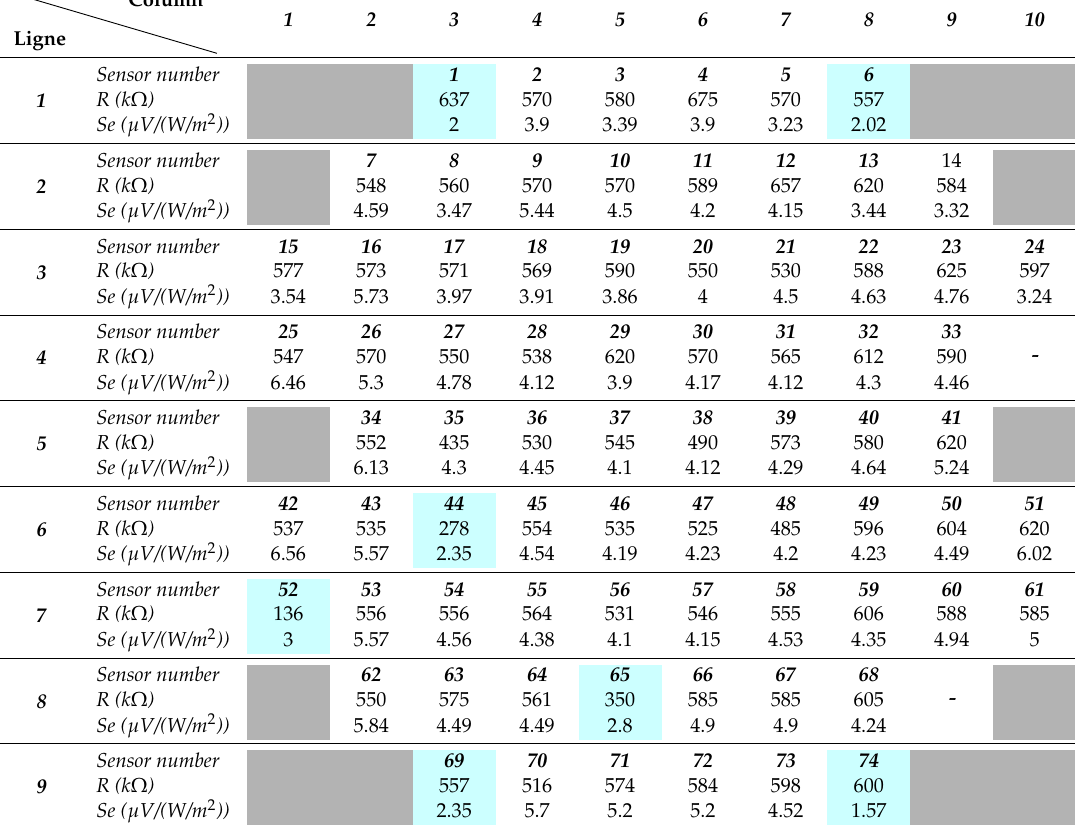
Table 2. Sensors’ sensitivities and electrical resistances measured on a complete 3 in wafer.